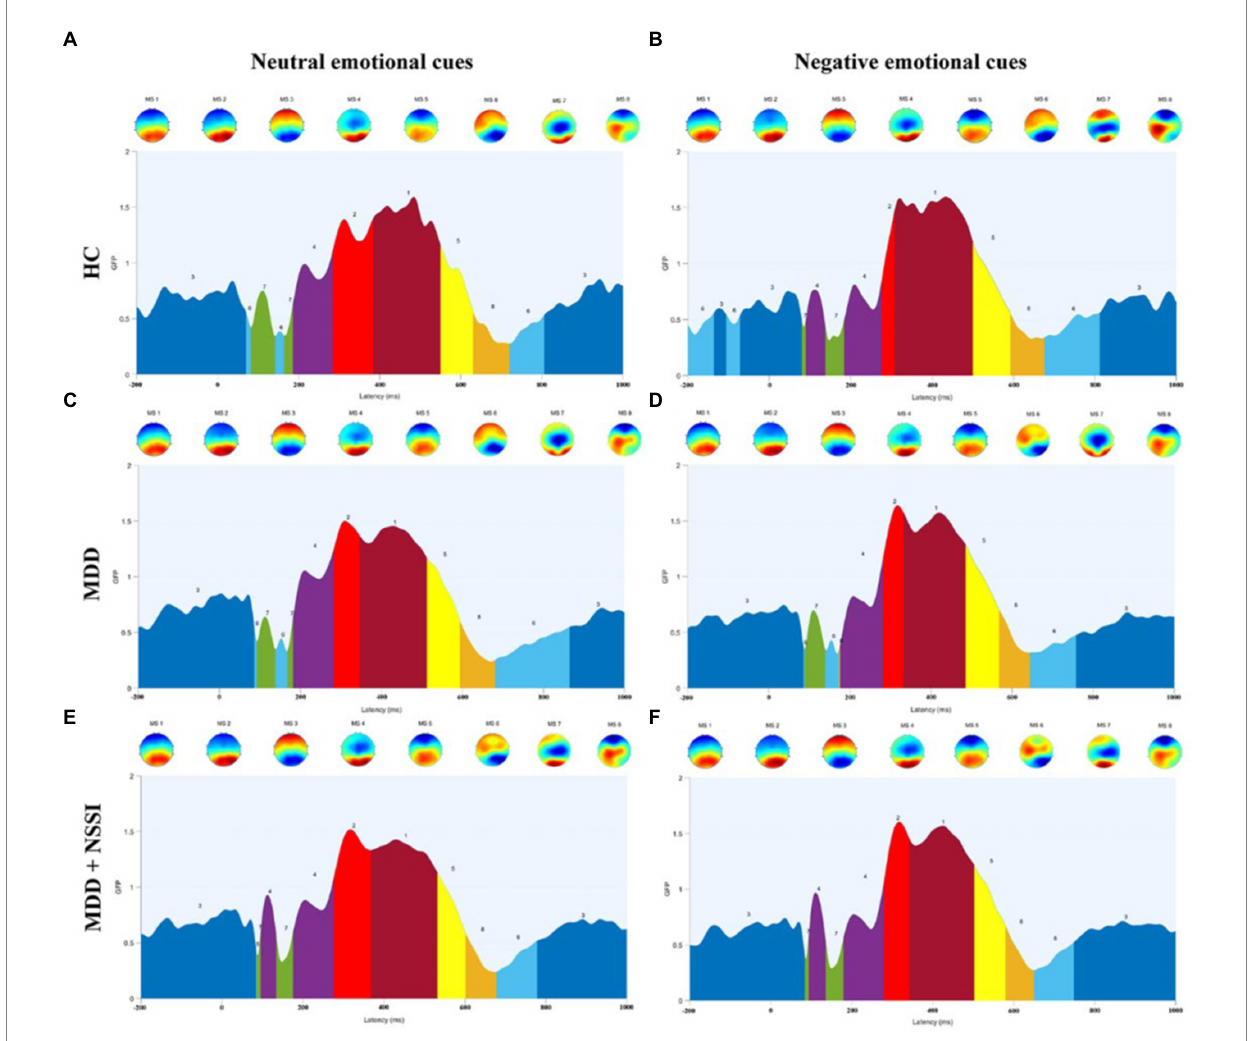
FIGURE 4 (A) Microstate categories of the HC group under neutral emotional cues. (B) Microstate categories of the HC group under negative emotional cues. (C) Microstate categories of the MDD group under neutral emotional cues. (D) Microstate categories of the MDD group under negative emotional